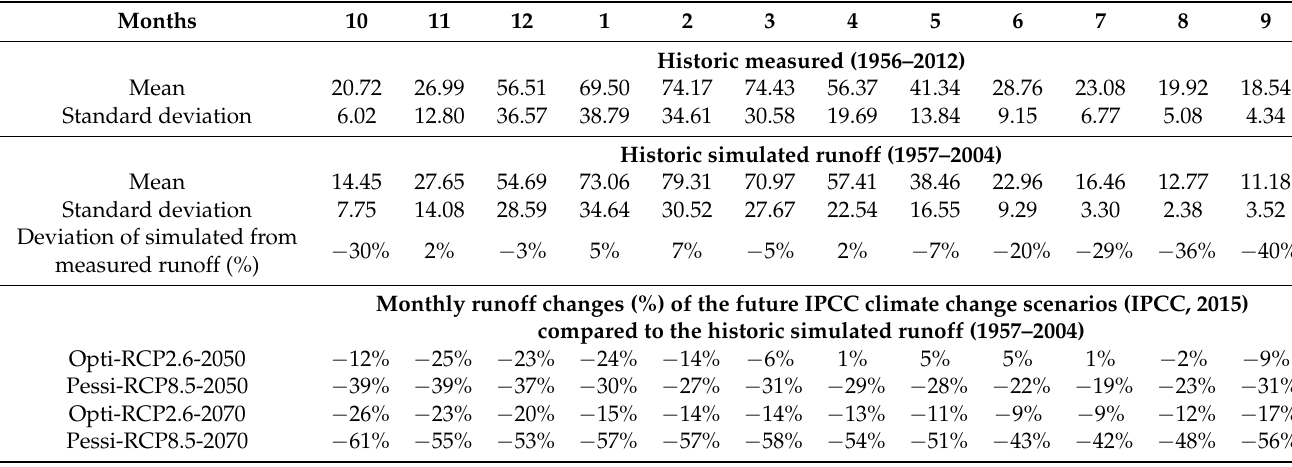
Table A2. Statistical characteristics of historic and future monthly water inflows into Ladhon Reservoir (in × 10 6 m 3 ) and corresponding changes